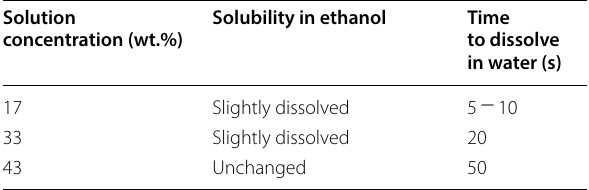
Table 1 Processing conditions for sacrificial layer Solution concentration